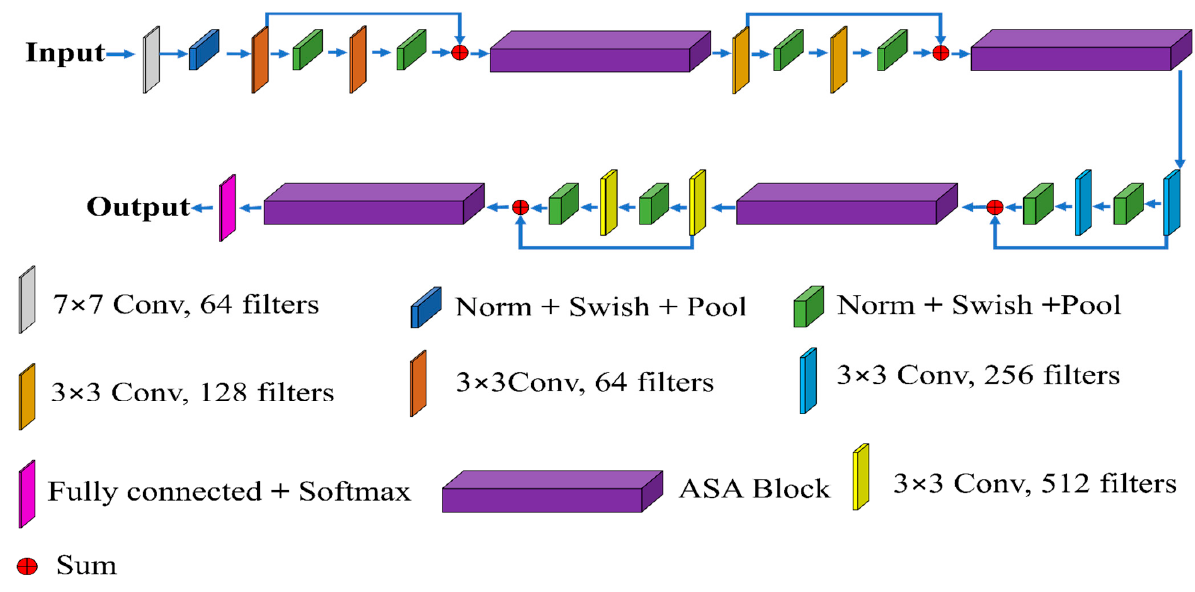
Figure 2. The structure of the improved DCNN model.